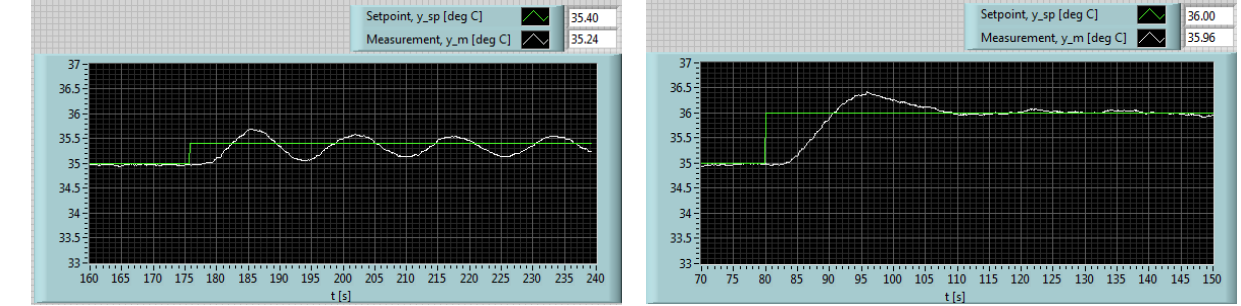
Figure 7: Temperature control system: Setpoint step response with Good Gain controller tuning.